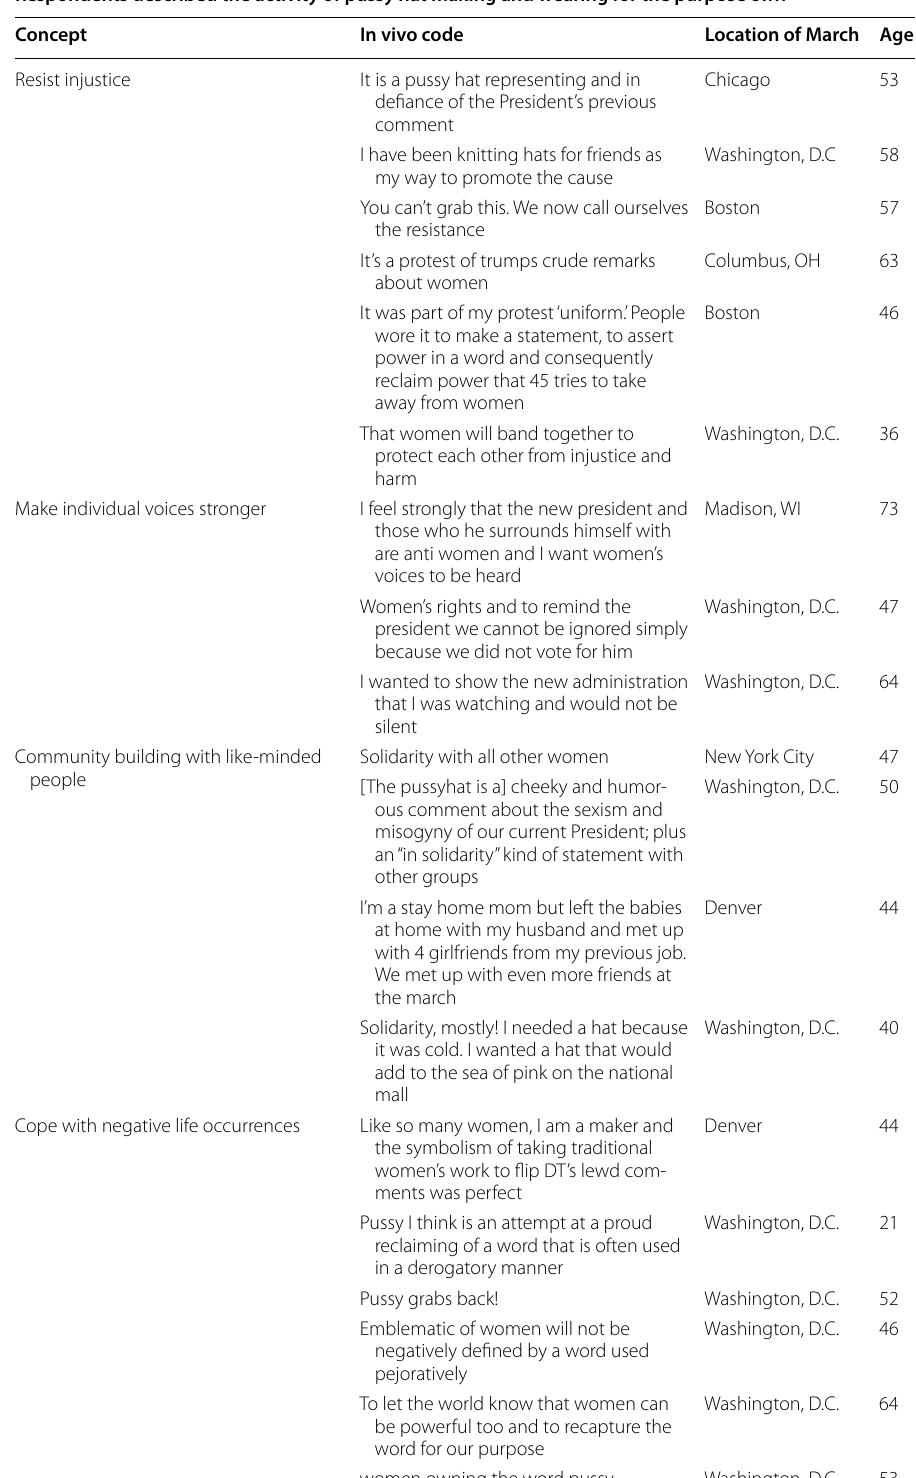
Table 2 Evidence of craftivism concepts through maker–wearer in vivo codes Respondents described the activity of pussy hat making and wearing for the purpose of… Concept In vivo